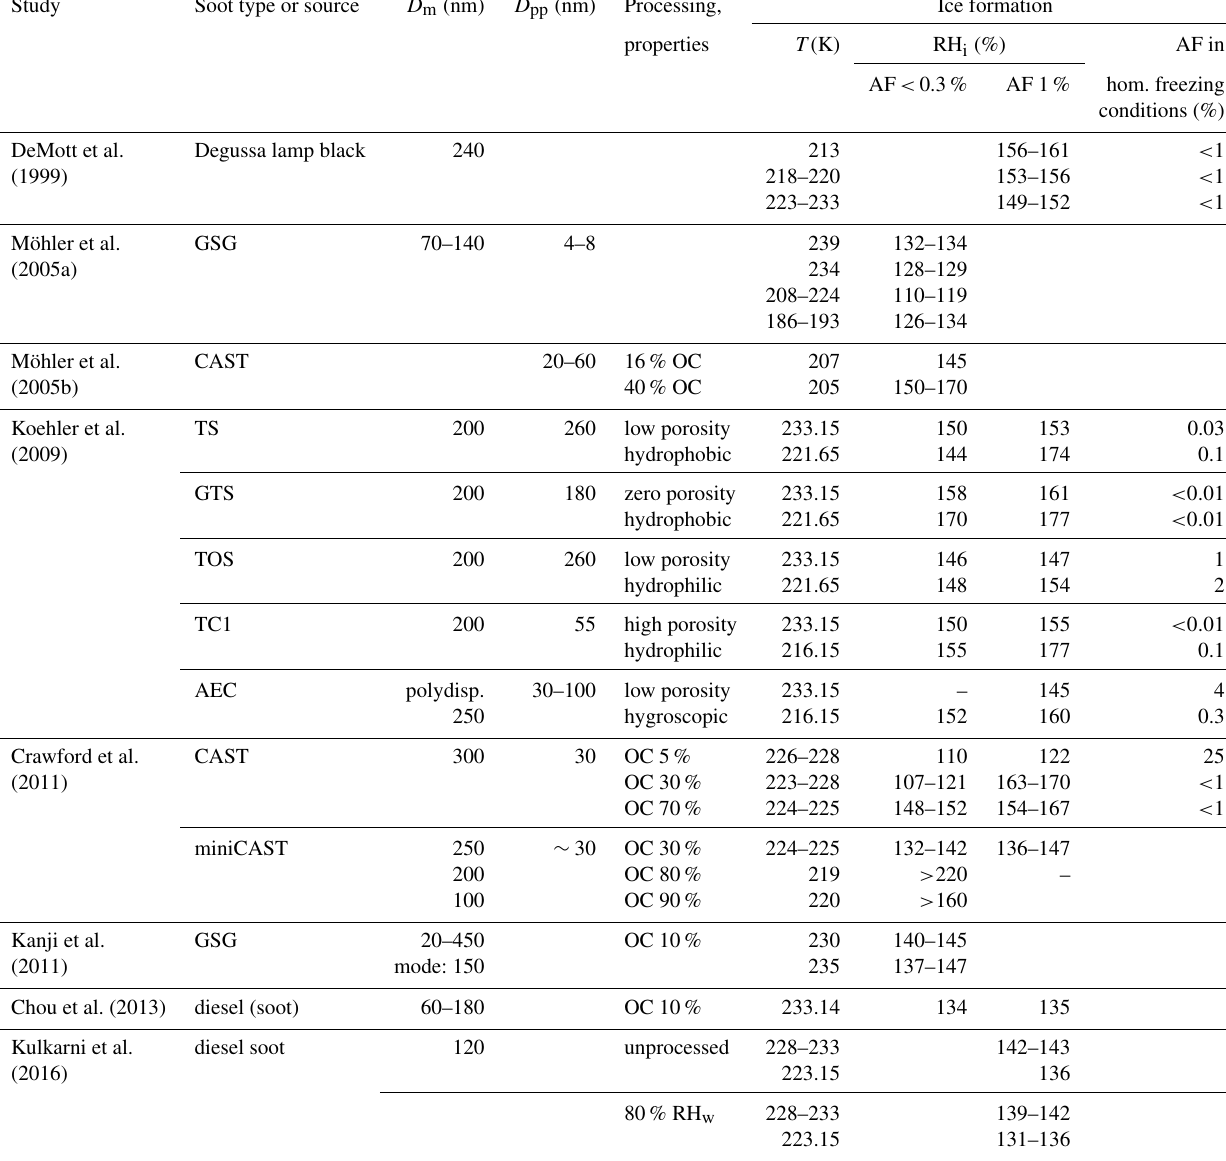
Table F1. Summary of studies that have investigated the ice nucleation ability of a variety of uncoated soot particles and different soot types at cirrus temperatures. For each study, the soot type; aggregate electric mobility diameter, D m ; average primary particle diameter, D pp ; and processing conditions are tabulated. The ice nucleation activity is listed in terms of the relative humidity with respect to ice, RH i , at which an activated fraction (AF) of either 0.1–0.3% or 1% is reached at a given temperature. In addition, the AF in the conditions of homogeneous freezing of solution droplets is also reported. See primary references for abbreviations of soot types as used in the